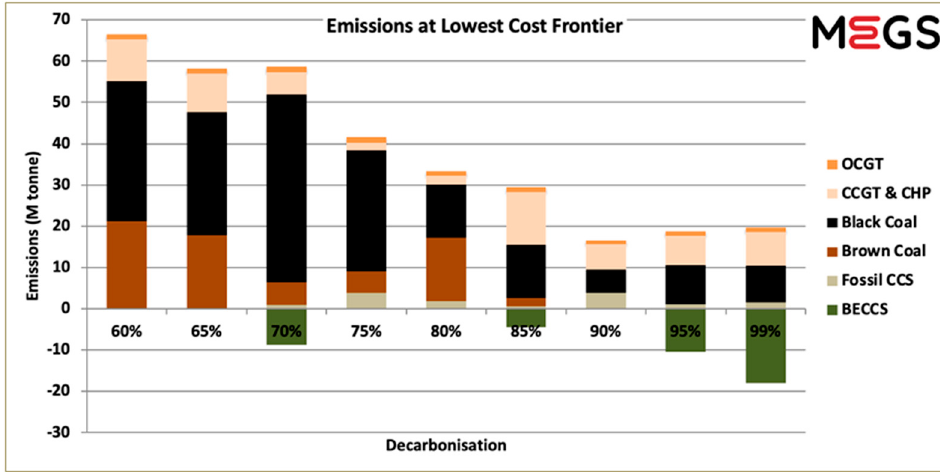
Figure 4. Emissions at lowest cost frontier by fuel type.